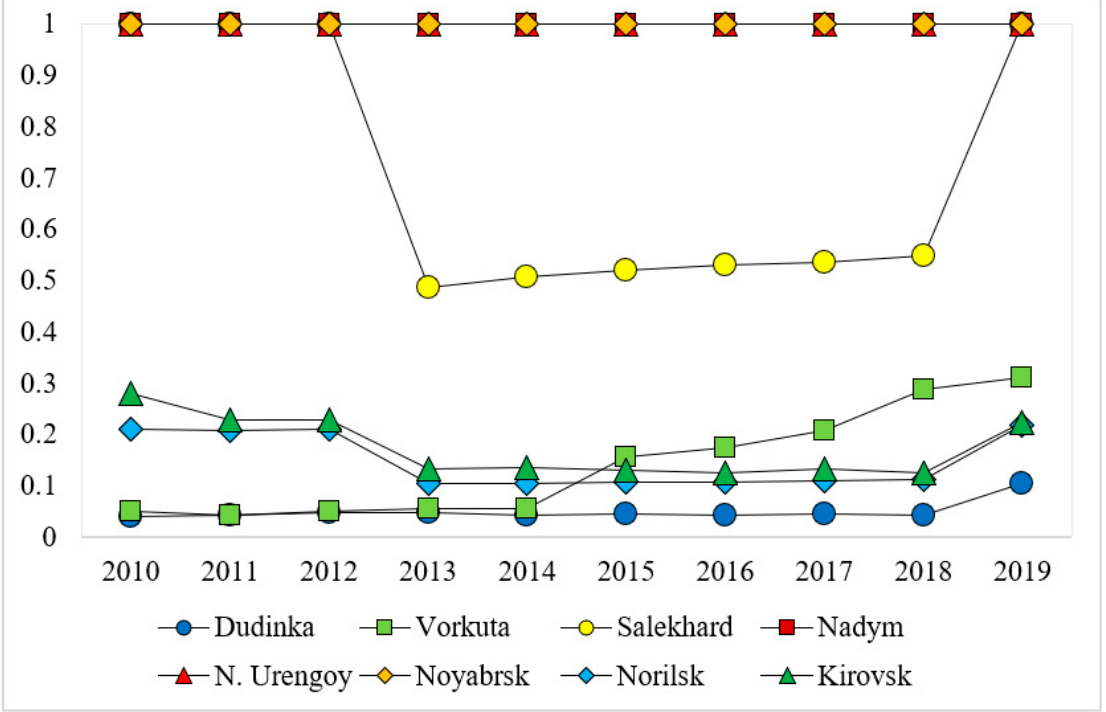
Figure 3. Variations in eco ‐ efficiency scores of cities along the central section of the NSR across the years 2010–2019.